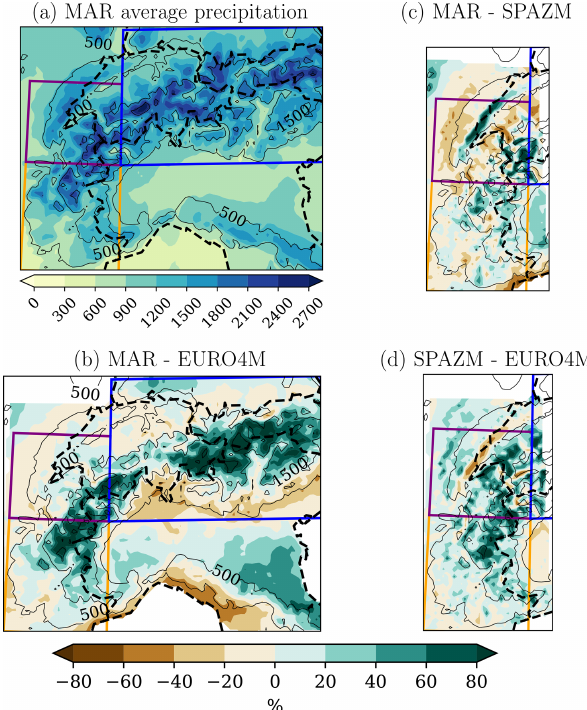
Figure 1. (a) Annual mean of precipitation (TP, mmyr − 1 ) over 1971–2008 in the Alps simulated with MAR applied with a resolution of 7km and laterally forced with ERA-20C. The coloured boxes correspond to the southern Alps (SA, orange), the northwest- ern Alps (NWA, blue) and the northeastern Alps (NEA, purple). Precipitation differences (%) between (b) the MAR experiment and the SPAZM dataset, (c) the MAR experiment and the EURO4M- APGD observational gridded datasets, and (d) the SPAZM and the EURO4M-APGD datasets. Panels (c) and (d) are shown only for the area where the SPAZM data are available. The 1000m spaced black contours show the topography in the 7km resolution model, start- ing from 500ma.s.l., and political frontiers are denoted with the black dashed lines. The pattern correlation values between MAR outputs and observational data are 0.59 and 0.63, respectively, with EURO4M and SPAZM ( p value < 1 × 10 − 200